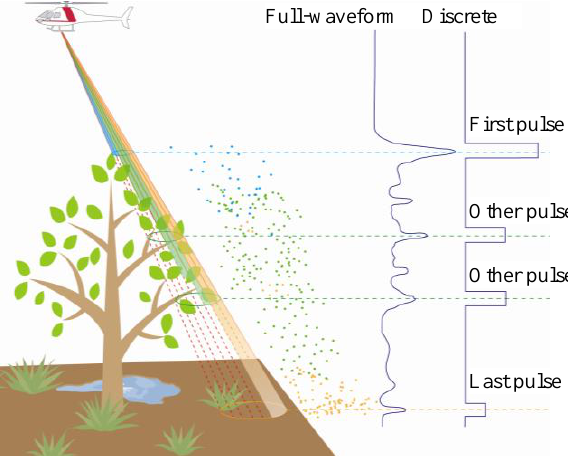
Figure 1. Airborne laser scanner conceptual diagram